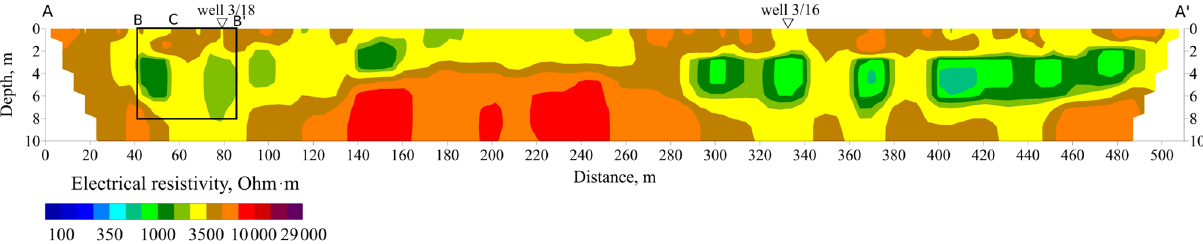
Figure 5. Two-dimensional section of the electrical resistivity over the whole ERT profile of around 500m length (A to A (cid:48) ). The black rectangle marks the corresponding subsurface area of the HFIP measurements (B to B (cid:48) ), including the midpoint location of the HFIP sounding (C) and the location of well